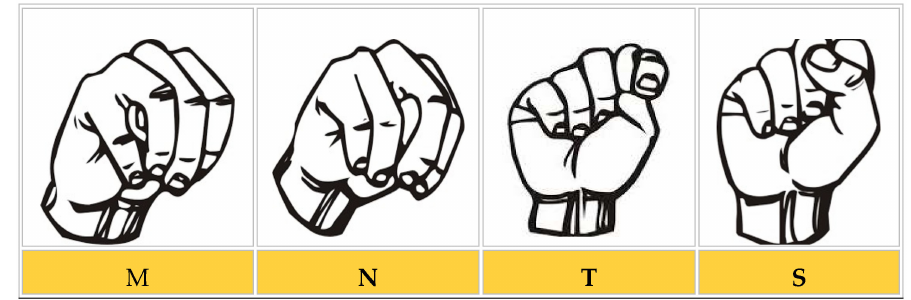
Figure 29. Similar postures in ASL, in terms of finger